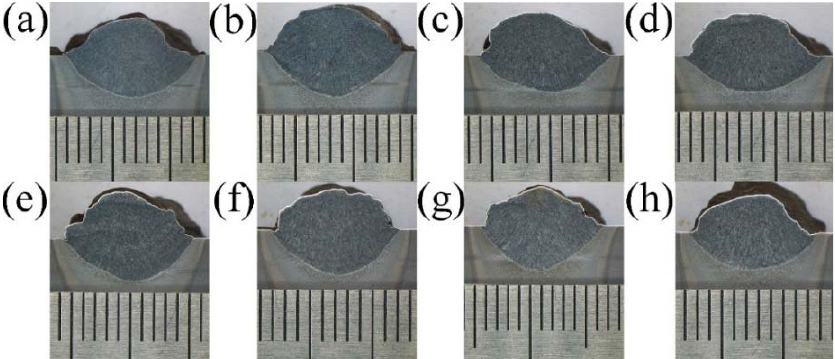
Figure 10. Macrographs of the cross-section of the weld beads at different ultrasonic-frequency pulse conditions: ( a ) conventional UWW; ( b ) 20 V–30 kHz; ( c ) 40 V–30 kHz; ( d ) 60 V–30 kHz; ( e ) 40 V–20 kHz; ( f ) 40 V–40 kHz; ( g ) 40 V–50 kHz; ( h ) 40 V–60 kHz (scale 1 mm).